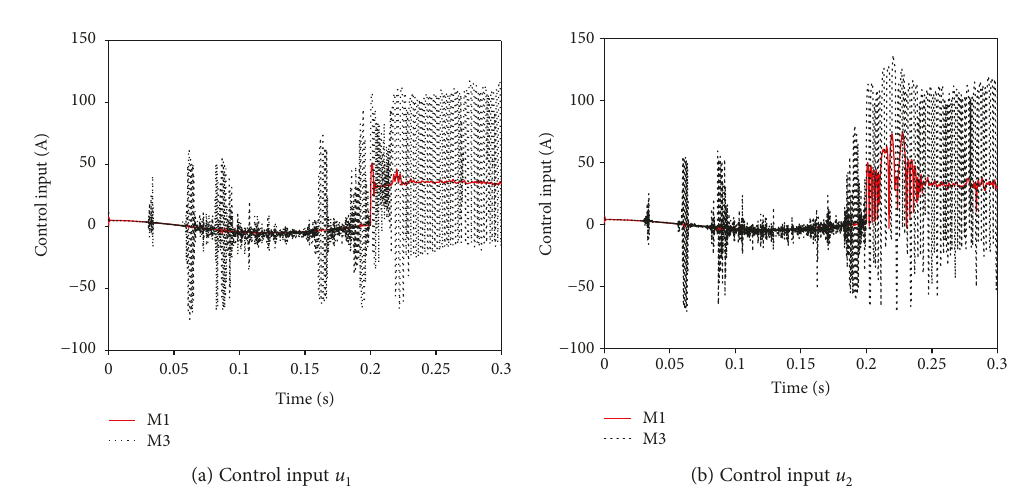
Figure 13: Control